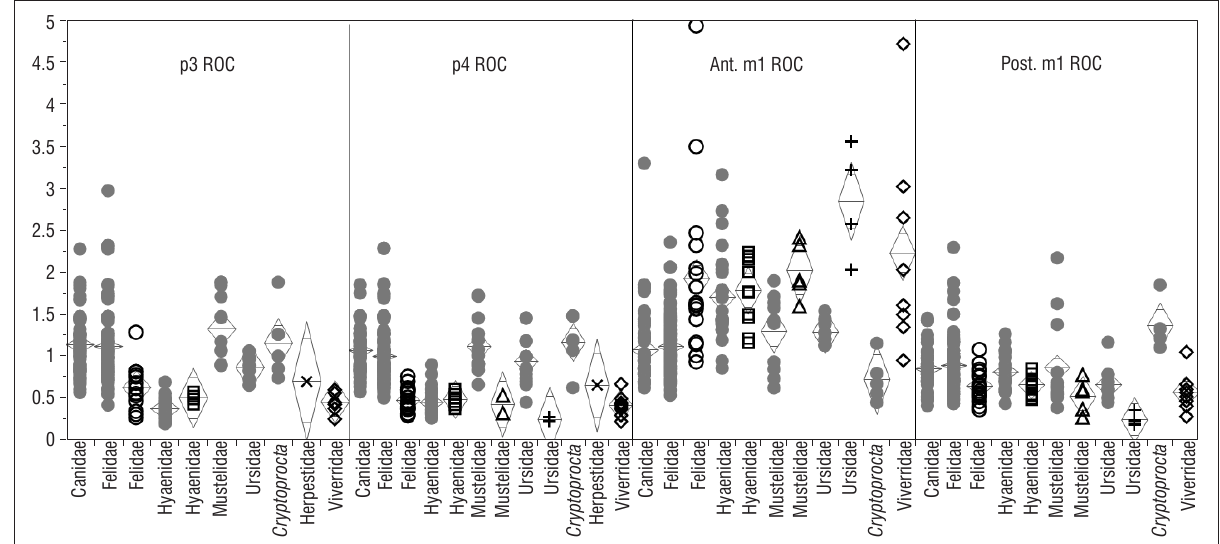
Extant taxa are represented by solid grey circles, Langebaanweg (LBW) felids by open circles, LBW hyaenids by open squares, LBW mustelids by open triangles, LBW ursids ( Agriotherium ) by ‘+’ signs, the single analysed LBW herpestid by an ‘x’ sign, and LBW viverrids by open diamonds. Because the only euplurid in the extant sample is represented by Cryptoprocta , that column is labelled with the generic and not familial name. No LBW canid fossil preserved cusps that are strong enough for moulding for the ROC measurement method. Each dotted diamond represents the mean and 95% confidence interval vertical span; the horizontal lines are the mean and ‘overlap marks’ that indicate statistical separation. Figure 3: Radii-of-curvature (ROC) of the third (p3) and fourth (p4) lower premolars and the anterior (paraconid) and posterior (protoconid) carnassial (m1) cusps by family.